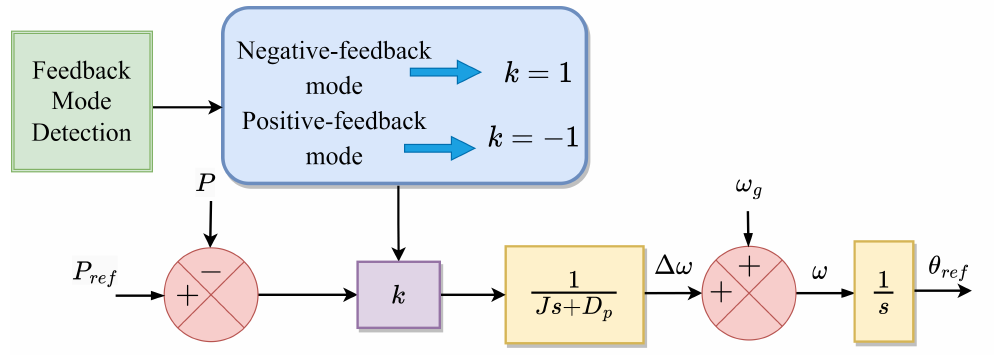
Figure 20. Mode-adaptive control [115].